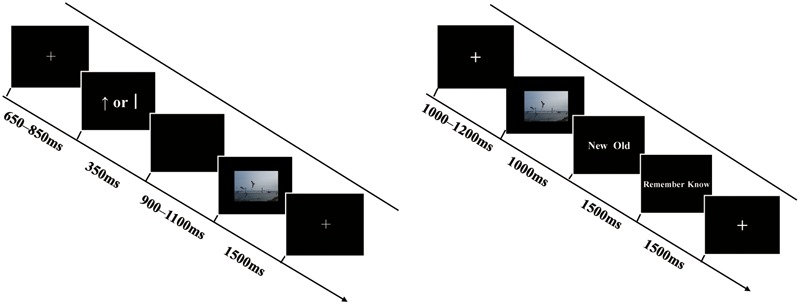
Schematic representations of a trial in the study phase (the left) and retrieval phase (the right). See text for details. The example picture resembles those in the experiment but it is not part of the CAPS.